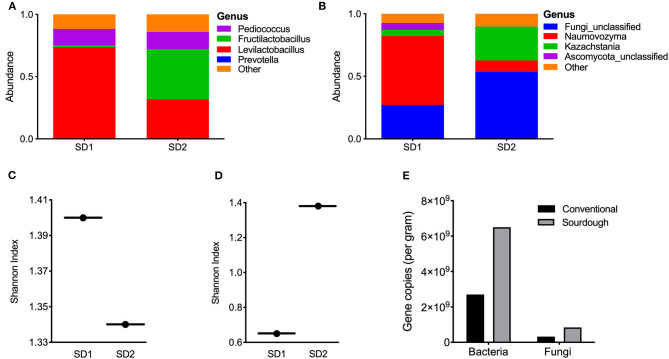
Bacterial and fungal composition of sourdough culture at day 0 (mother culture, SD1) and day 1 (daughter culture, SD2). (A) Bacterial genus abundance and (B) alpha diversity in SD1 and SD2 for bacteria in cultures, (C) Fungal genus abundance, (D) alpha diversity in SD1 and SD2 for fungi in cultures. The starter (mother) culture was exposed to air for 14–18 h after addition of flour, water and mixing to make daughter culture (SD2). (E) Results of PCR for bacterial and fungi abundance in pasta samples, expressed per gram of sample (see Methods).